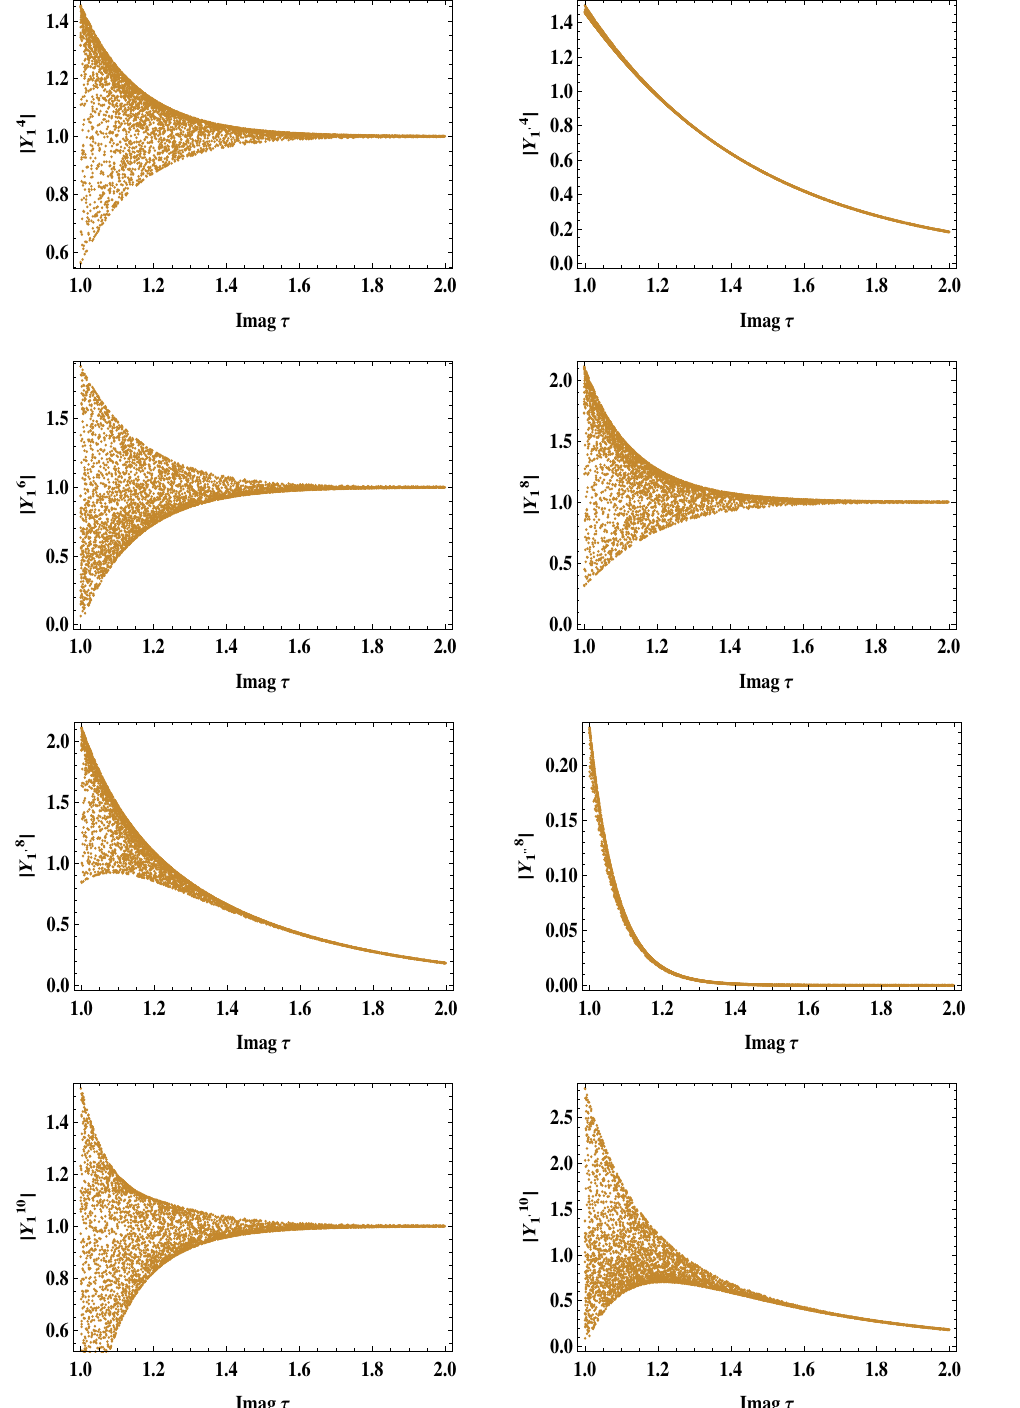
Figure 3 . Variation of Yukawa couplings of higher modular weight with imaginary part of complex modulus τ